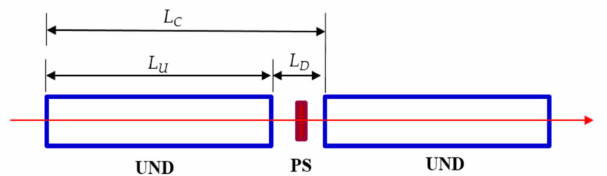
Figure 2. UND and PS stand for undulator and phase-shifter, respectively. L C is the length of the undulator cell. The undulator ( L U ) is 5 m long, and the drift section ( L D ) is 1.05 m long. In the drift are a beam position monitor and a quadrupole magnet, which are not